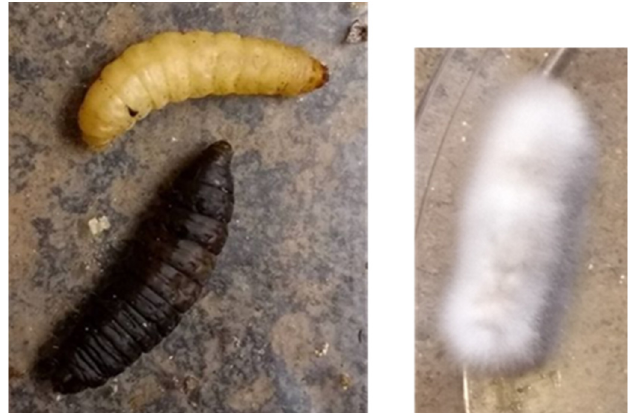
Figure 1. Melanised ( left , bottom ) and non-melanised ( left , top ) Galleria mellonella caterpillars, as well as one showing complete fungal emergence ( right ).